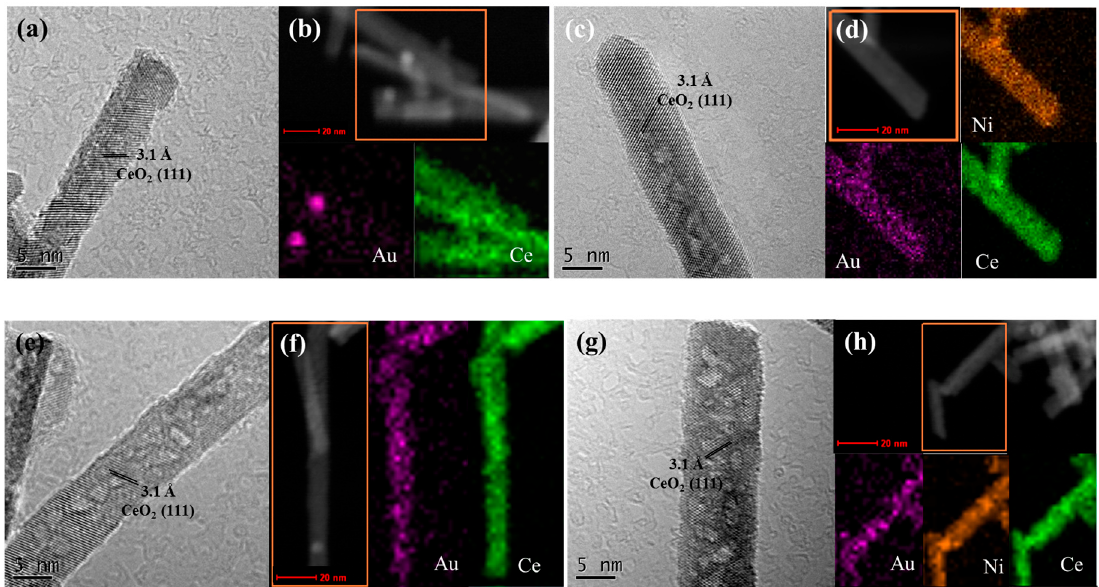
Figure 6. HRTEM images ( a , c , e , g ) and STEM-EDS mapping results ( b , d , f , h ) of used AuNi/CeO 2 samples after CO oxidation ( a – d ) and WGS ( e – h ) reactions: ( a , b , e , f ) AuCe ; ( c , d , g , h ) AuNiCe .